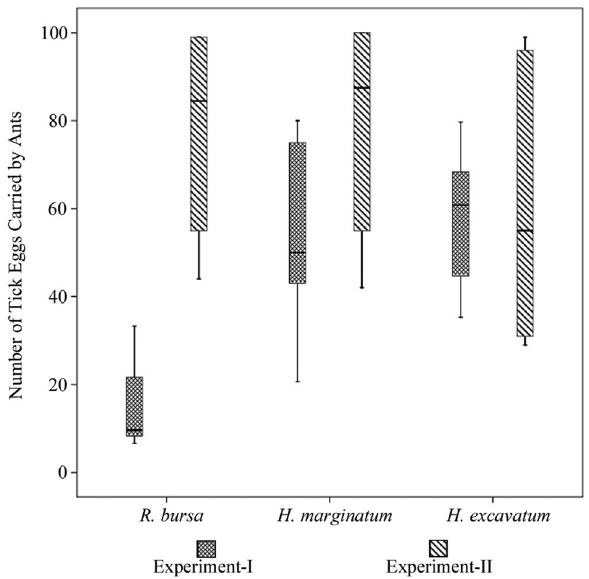
Figure 3. The number eggs with wax coating (Experiment I) and dewaxed (Experiment II) of the tick species carried by the ants.